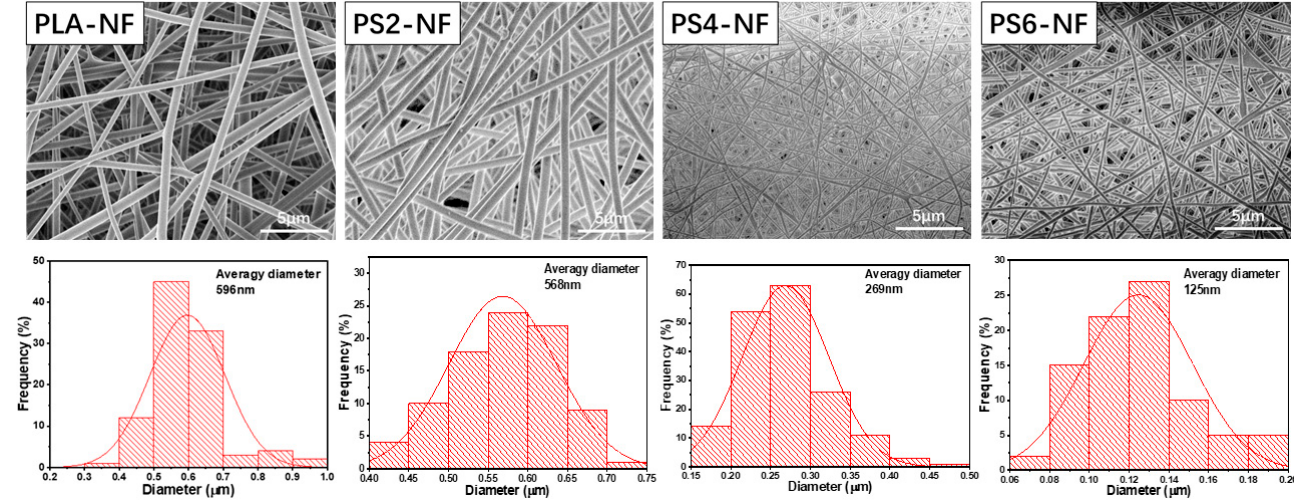
Figure 1. SEM images and diameter distribution of PLA NF with different POSS ratio. Table 1. Mechanical properties of PLA NF with different POSS ratio.